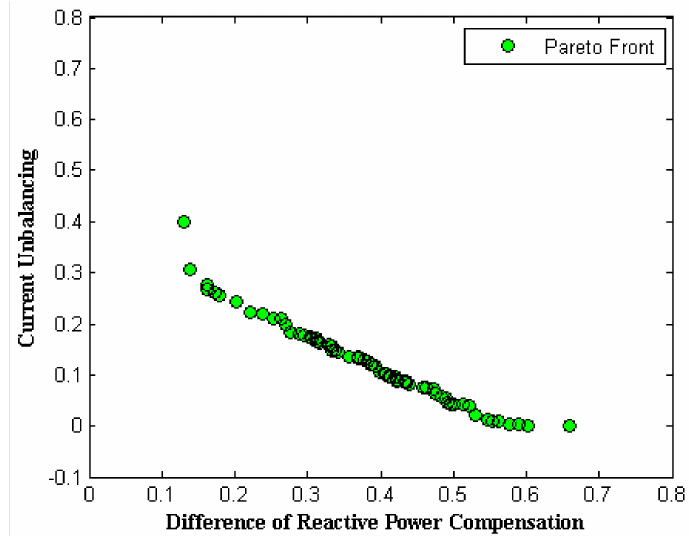
Figure 8. Determined Pareto